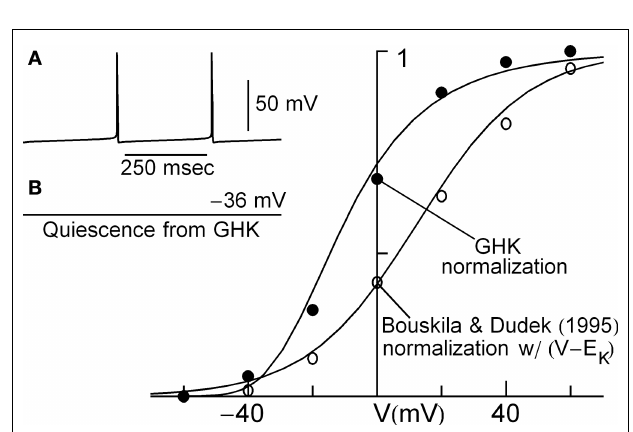
FIGURE 7 | Effect of GHK normalization of I in a model of electrical K activity of neurons from the suprachiasmatic nucleus by Sim and Forger (2007). Inset (A) Prediction of the Sim and Forger (2007) model. (B) Prediction − V curve from of the model when GHK normalization is used to obtain the g K the Bouskila and Dudek (1995) measurements of I described to the right. K Main panel: description of I by Bouskila and Dudek (1995). They normalized K their results with ( V − E ) – open circles. The curve describing those results is K given by 1/(1 + exp( − ( v − 14)/17)). Those points were multiplied by ( V − E ) with K E = − 97 mV, and then normalized by the GHK procedure to give the fi lled K + β circles. The curve describing those results is given by ( α /( α ) 4 with n n n α = − 0.01( V + 30)/(exp( − 0.08( V + 30)) − 1) and β = 0.125 exp( − ( V + 40)/30). n n This description of I predicts quiescence in the Sim and Forger (2007) model K as described in the